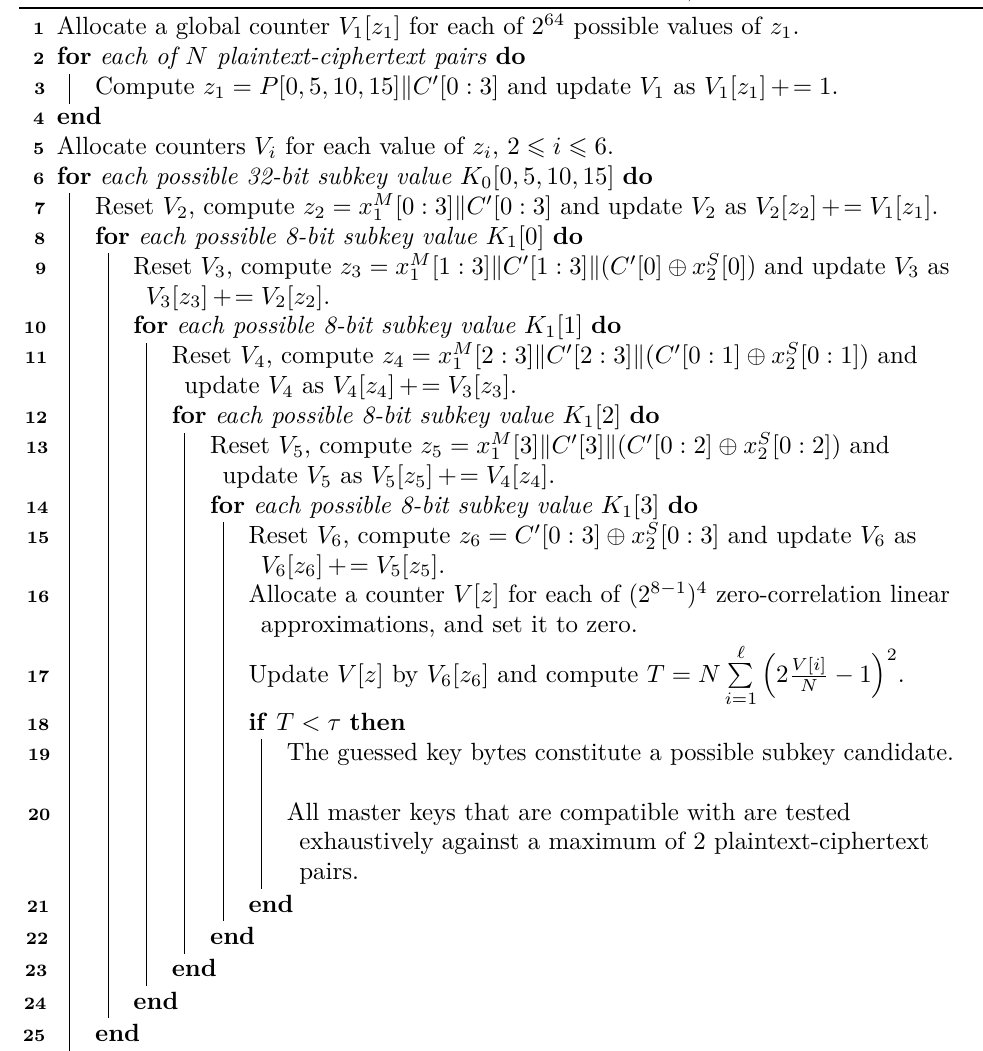
Algorithm 2: Zero-correlation linear attack on AES-PRF 2 ,